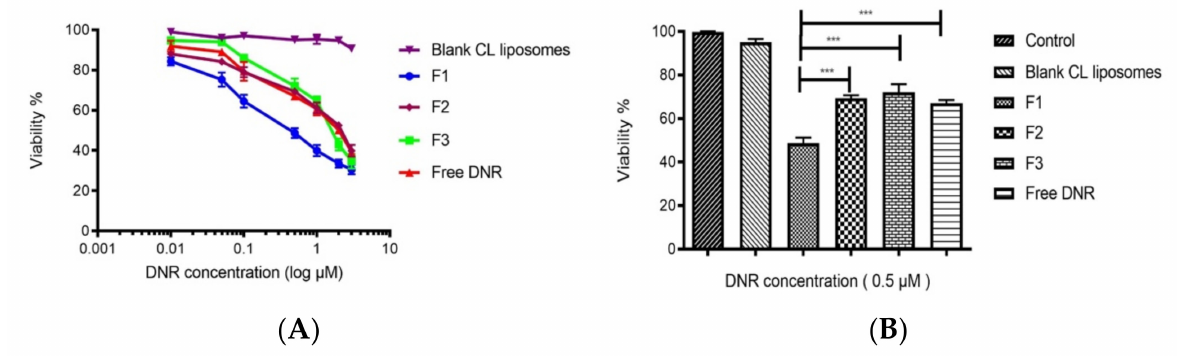
Figure 2. ( A ): CL potentiates the cytotoxic effect of DNR TSLs against MDA-MB-231 cell lines. Cells were incubated at 42 ◦ C for 10 min then returned to 37 ◦ C. ( B ): In vitro cytotoxicity of different formulations against MDA-MB-231 breast cancer cells. Cells were incubated at 42 ◦ C for 10 min then returned to 37 ◦ C for 48 h. *** p < 0.001. Values represent mean ± standard deviation ( n =